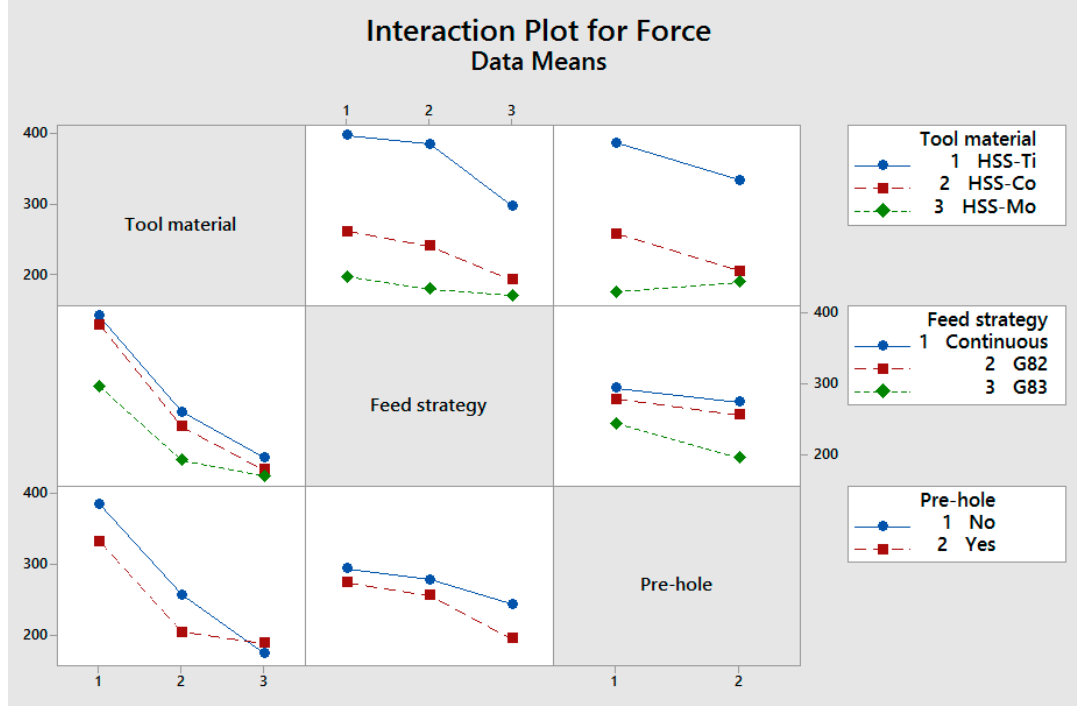
Figure 10. Interaction of cutting conditions versus cutting forces (N).